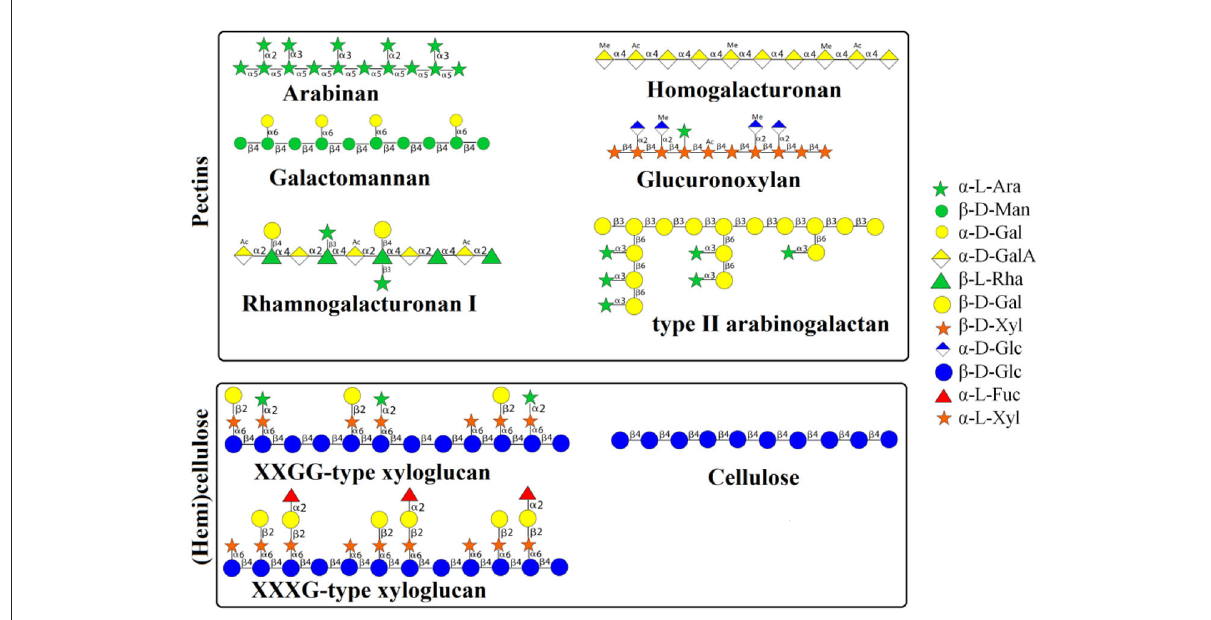
FIGURE2 Schematic representation of structures of polysaccharides in RSM. RSM, rapeseed meal; WSS, water soluble solids; WUS, water unextractable solids; ChSS, Chelating Agent Soluble Solids; DASS, Dilute Alkali Soluble Solids; 4 MASS, 4 Molar Alkali Soluble Solids; 6 MASS, 6 Molar Alkali Soluble Solids; RES, residue; Ara, arabinose; Xyl, xylose; Man, mannose; Fuc, fucosyl; Gal, galactose; Glc, glucose; UA, uronic